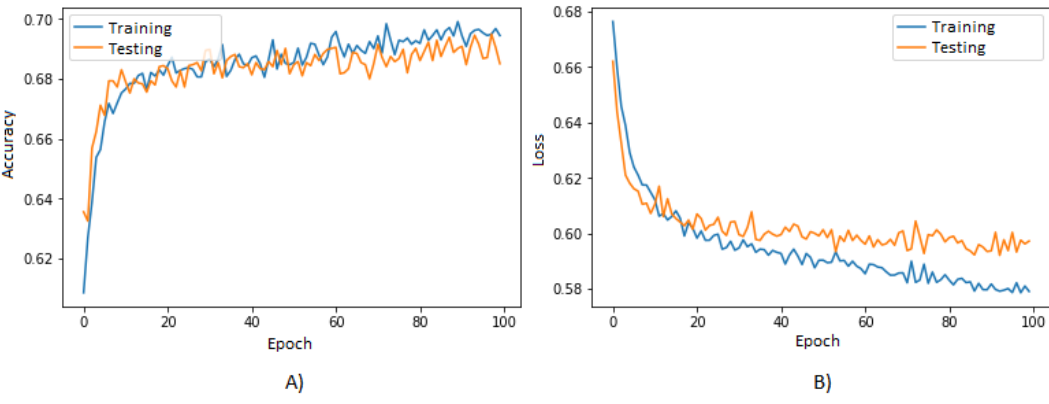
Figure 6. Graphs of the performance of the accuracy ( A ) and the loss function ( B ) of the ANN in each